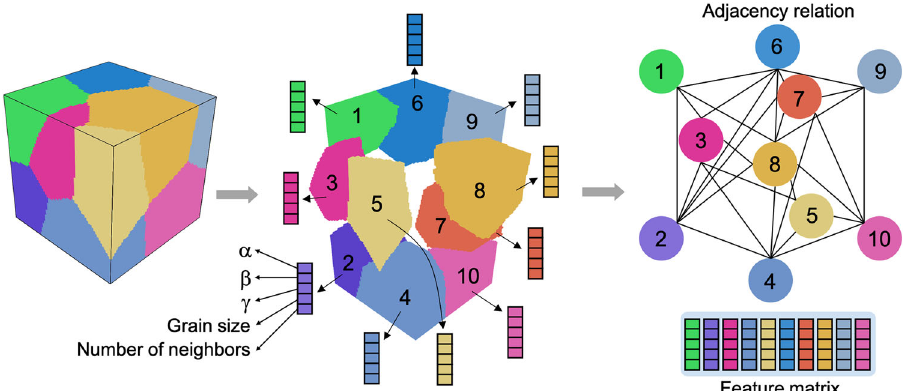
Fig. 1 Graph-based representation of an N -grain polycrystalline microstructure. A 10-grain microstructure is considered as an example ( N = 10). The M different physical features ( M = 5 herein) of each grain (label “ i ” , i = 1,2, … N ) are stored using N different M -component feature ( k = 1,2 … M ), as shown in the left panel. These feature vectors are then combined into an N × M feature matrix F. The adjacency vectors f k i relations of the grains (nodes) are stored using an adjacency matrix A; the matrix element A ij equals 1 if grain i and grain j are neighbors and equals 0 otherwise. The neighboring grains are connected by lines (in the top right). Overall, a graph G = ( F , A